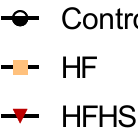
Figure 4. Graphical representation of liquid consumption during treatment. The control and HF groups consumed tap water, whereas the HFHS group consumed a 15% liquid sugar solution. Between weeks 1 and 12, HFHS animals consumed more liquid than the HF animals and controls. Data are presented as mean ± SEM. φφφφ p < 0.0001 HFHS versus controls; εεεε p < 0.0001 HFHS versus HF.